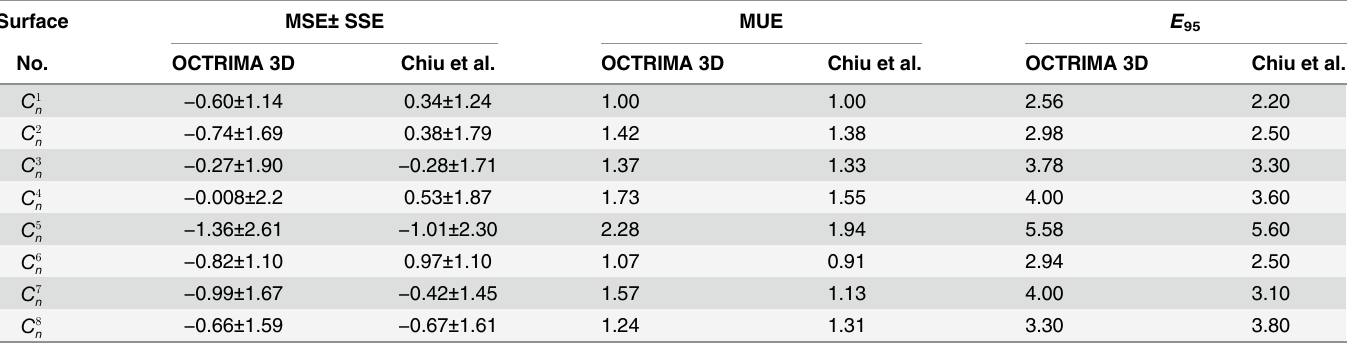
Table 3. Comparison results between OCTRIMA 3D and the algorithm by Chiu et al. on Bioptigen OCT images. The error is quantified with (MSE ± SSE, MUE, E 95 ) in unit of